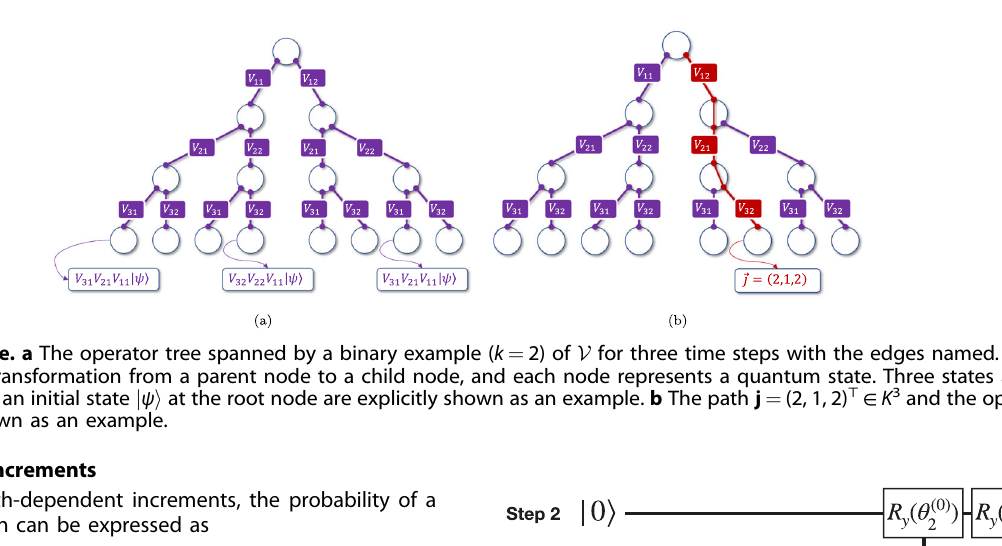
(cid:4) H D Þ for l = 1, … , l